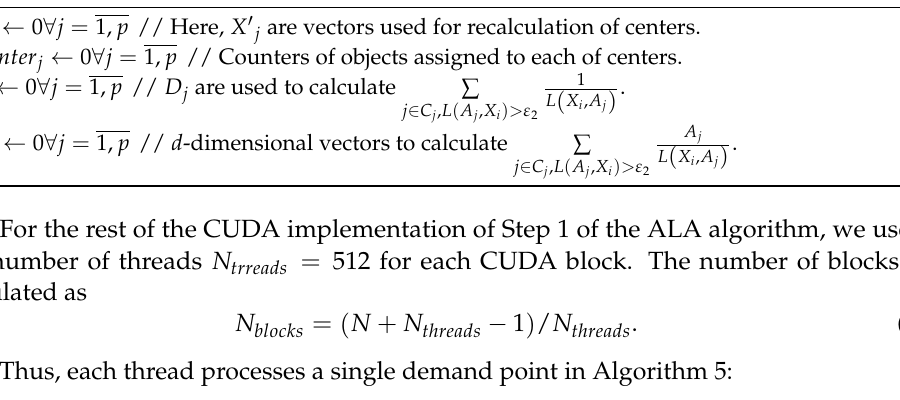
Algorithm 4 CUDA implementation of Step 1 in the ALA algorithm, part 1 (initialization)